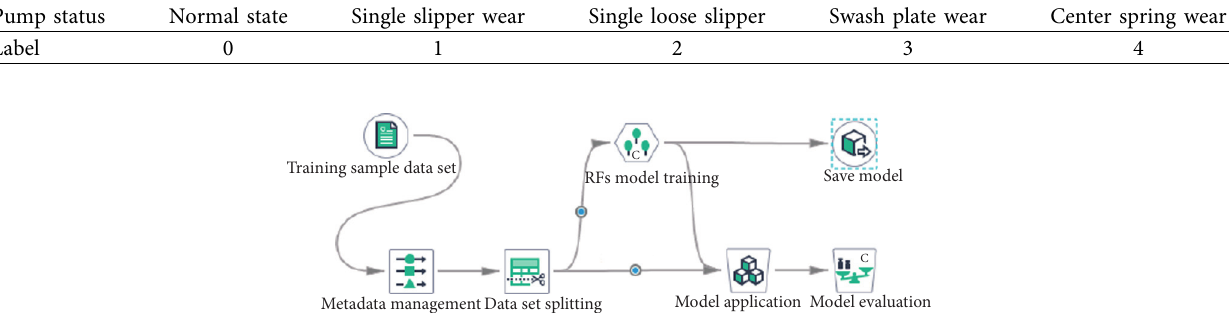
Table 2: Label of axial piston pump state.